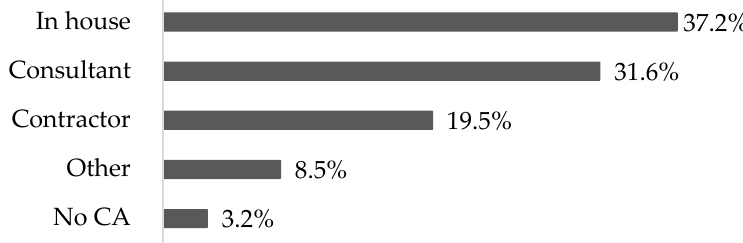
Figure 7. Distribution of the individuals conducting condition assessment.